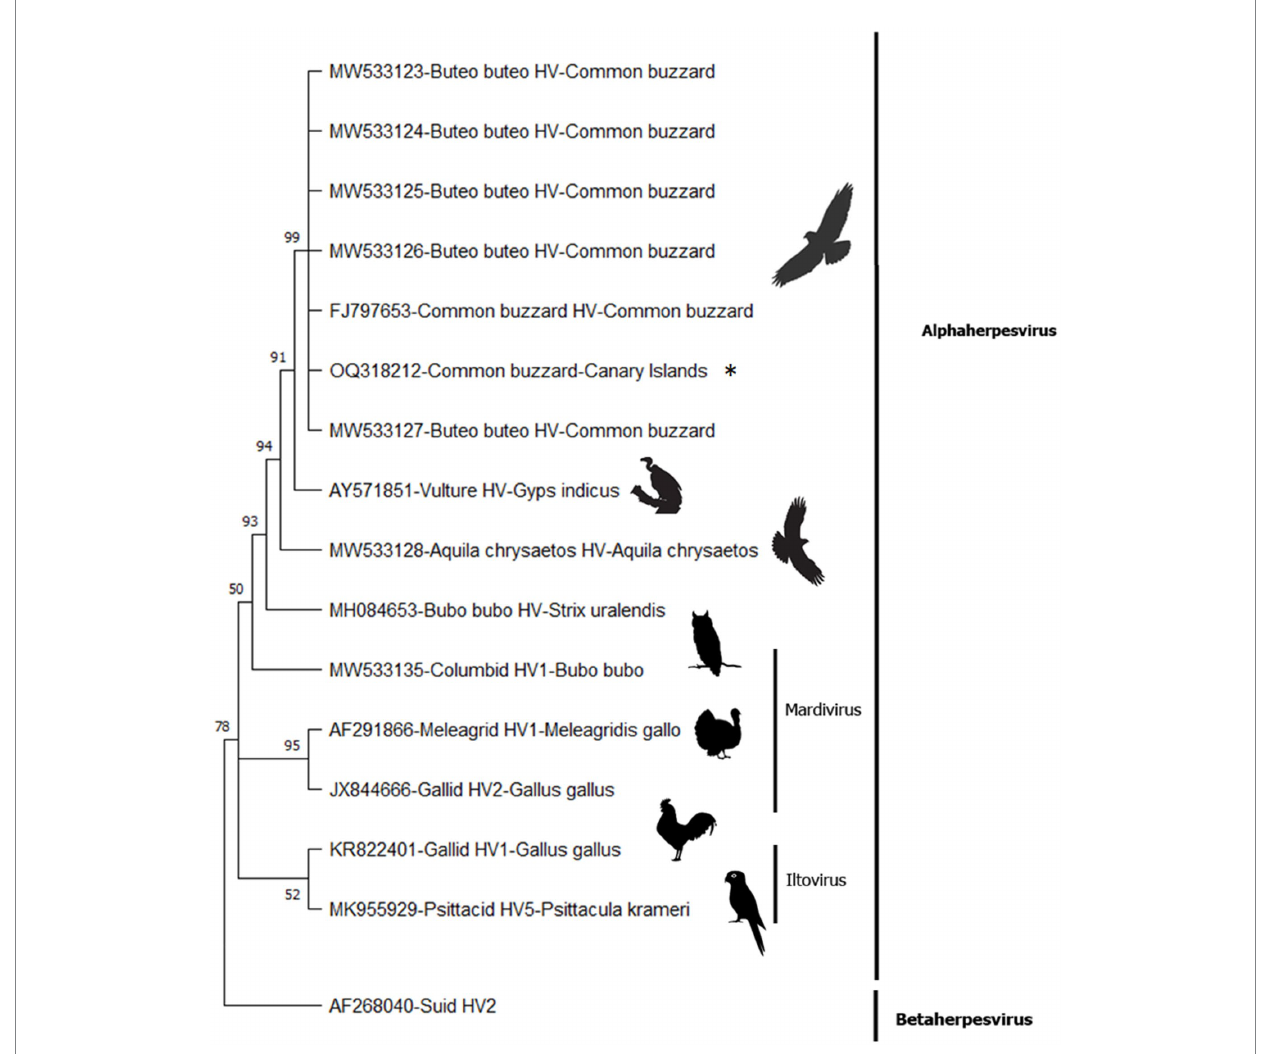
FIGURE 3 Condensed phylogenetic tree (50% bootstrap cutoff value) constructed from DNA polymerase partial sequences of herpesvirus species using the maximum likelihood method with Tamura’s 3-parameter model (T92 + G + I) for nucleotides. The asterisk denotes the fragment amplified from the common buzzard from Gran